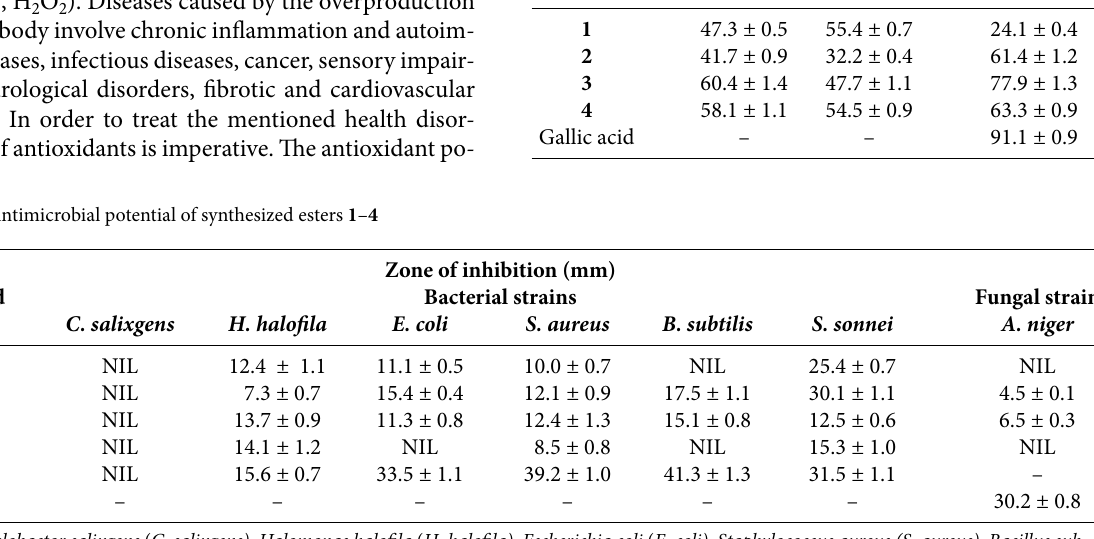
Table 4. Enzyme inhibition and antioxidant potential of synthesized esters